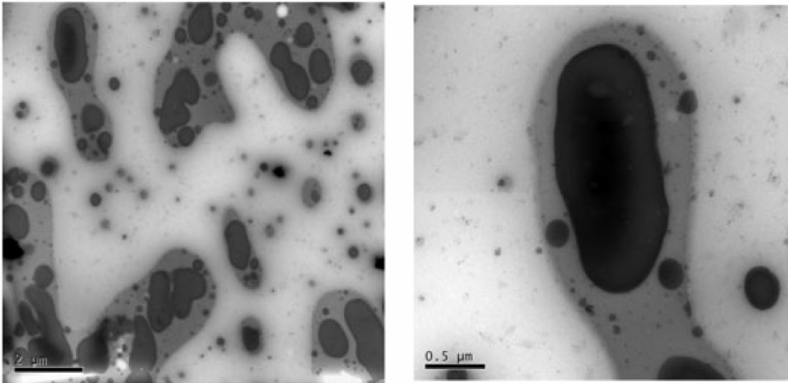
Figure 23. TEM images of CIIR/NBR/CR (80/20/30) blends [57].